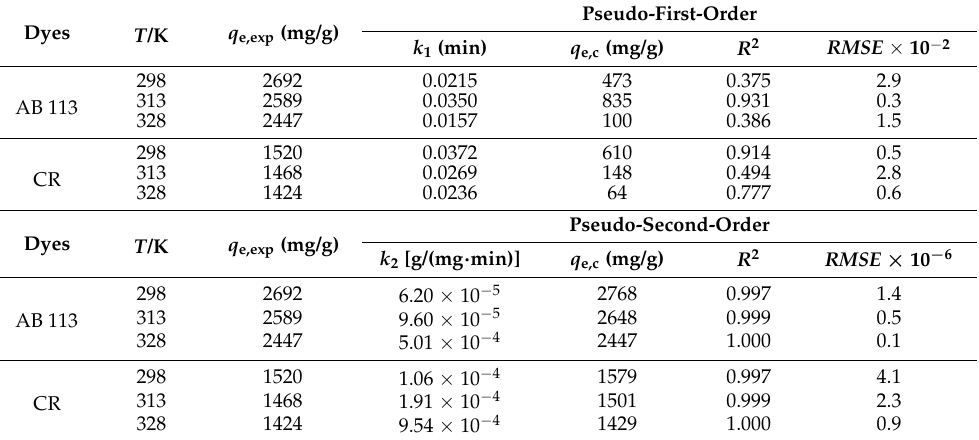
Table 1. Kinetic fitting relevant parameters of dye adsorption on CPAM-Dia/SA-La. Dyes T